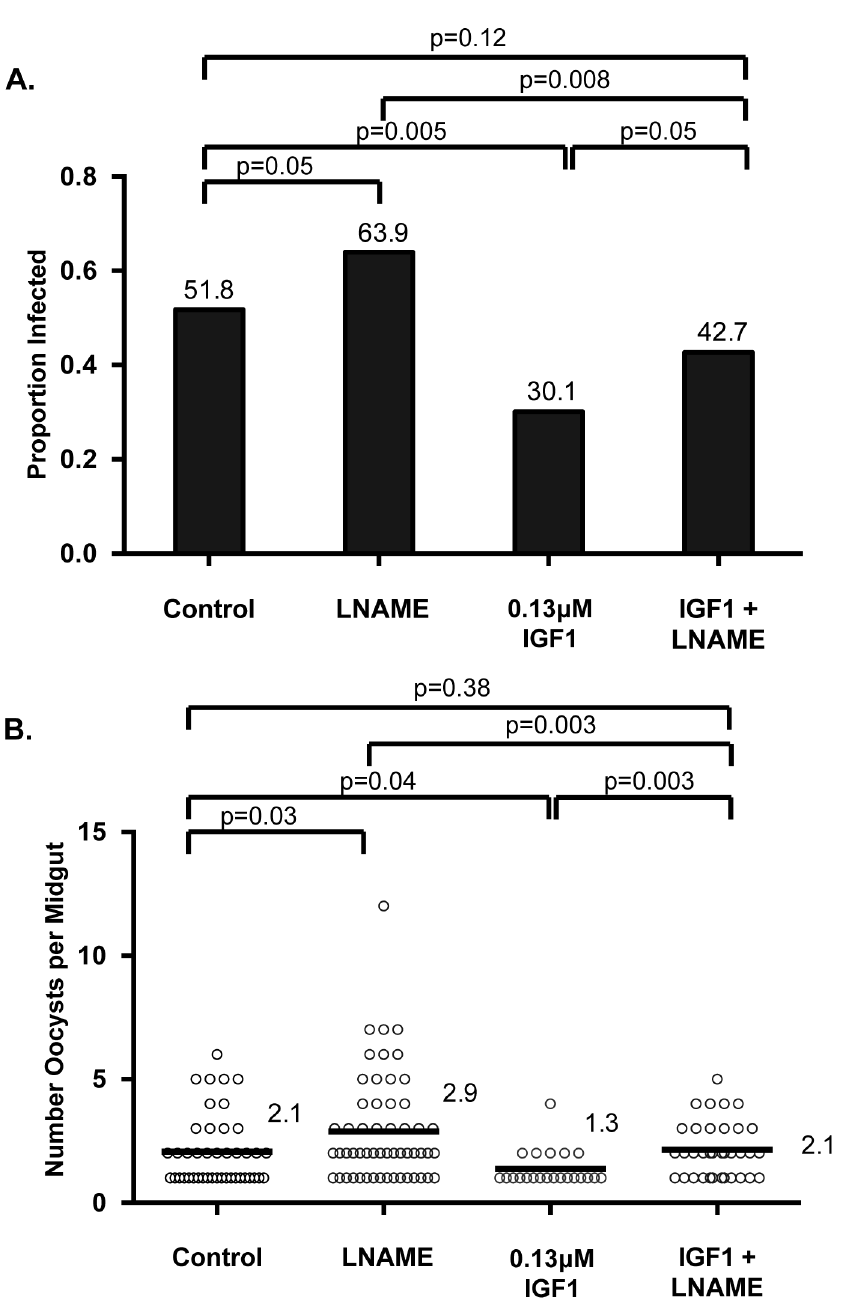
Figure 5. IGF1-induced resistance to P.falciparum was reversed by NOS inhibition. Age- and cohort-matched mosquitoes were fed infected blood meals supplemented with water, L-NAME, 0.13 m M IGF1 or 0.13 m M IGF1 + L-NAME as described in Materials and Methods. This experiment was replicated four times with separate cohorts of mosquitoes. No significant differences in oocyst intensity were identified among replicate control groups (Kruskal-Wallis, p . 0.05), so data were pooled for analysis. Intensity data shown are from infected midguts only. (A) Prevalence of infection (proportion of mosquitoes dissected with at least one P. falciparum oocyst; values indicated above bars). Fisher’s exact test was used to compare treatments against L-NAME. (B) Intensity of infection (mean oocysts per infected midgut; values indicated to the right of data for each group). Mann- Whitney test was used to compare treatment groups to matched controls.